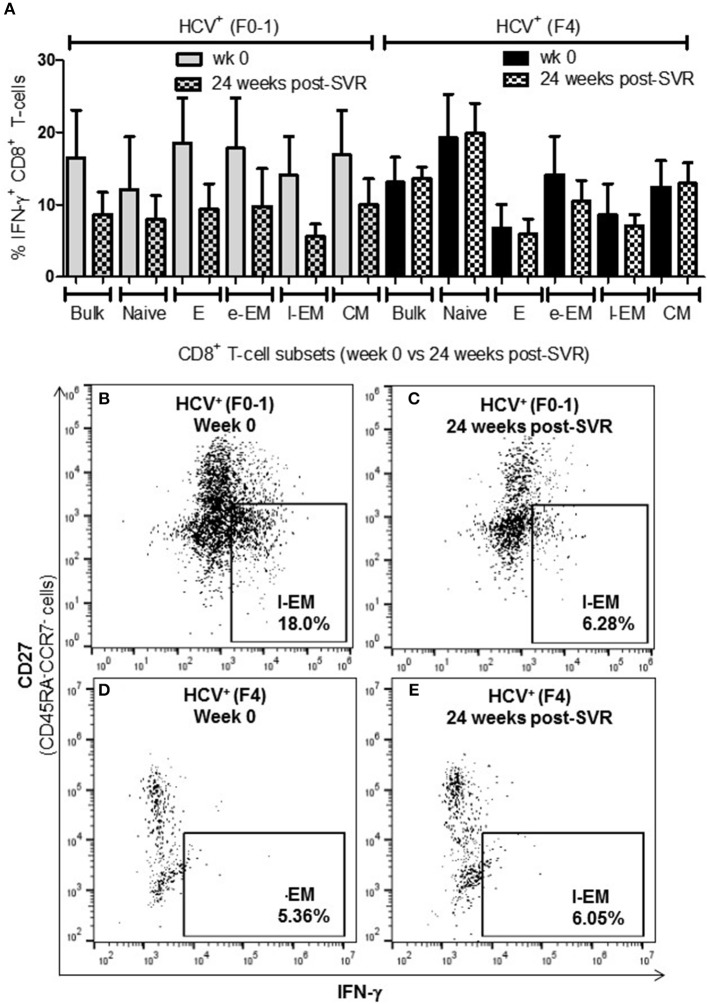
The proportion of IFN-γ+ CD8+ T-cells tended to decrease after DAA therapy in HCV-infected individuals with minimal fibrosis yet was sustained in a state of advanced liver fibrosis. Treatment-naïve HCV-infected individuals were treated with direct-acting anti-HCV (DAA) therapy for 12 weeks, and PBMCs were collected at wk 0 and 24 weeks post-SVR. Isolated CD8+ T-cells from PBMCs of HCV+ individuals with minimal or advanced liver fibrosis (F0-1, ≤7.0 kPa, n = 4; F4, ≥12.5 kPa, n = 4) when DAA treatment was initiated were stimulated with anti-CD3/-CD28 for 48 h and CD8+ T-cell functions were assessed. (A) A bar graph summarizes the proportion of IFN-γ+ CD8+ T-cells in HCV+ individuals with minimal or advanced liver fibrosis, before and after DAA therapy (B–E) Representative dot plots demonstrate the expression of IFN-γ in l-EM cells.